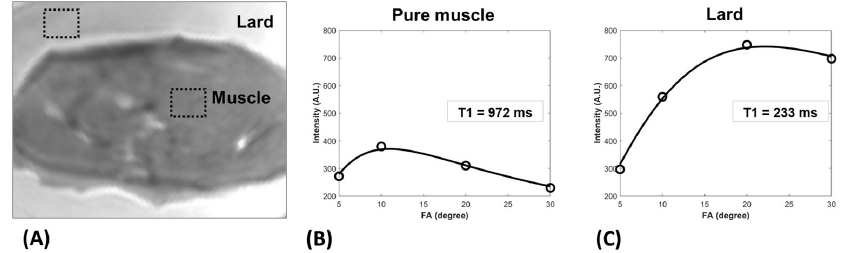
Figure 1. ( A ) T1-weighted UTE MRI image of a bovine muscle specimen embedded in lard (i.e., FF = 100%). UTE-T1 recovery fitting curves in ( B ) a pure muscle region of interest (ROI) (T1 = 972 ms) and a ( C ) pure fat ROI (T1 = 233 ms).